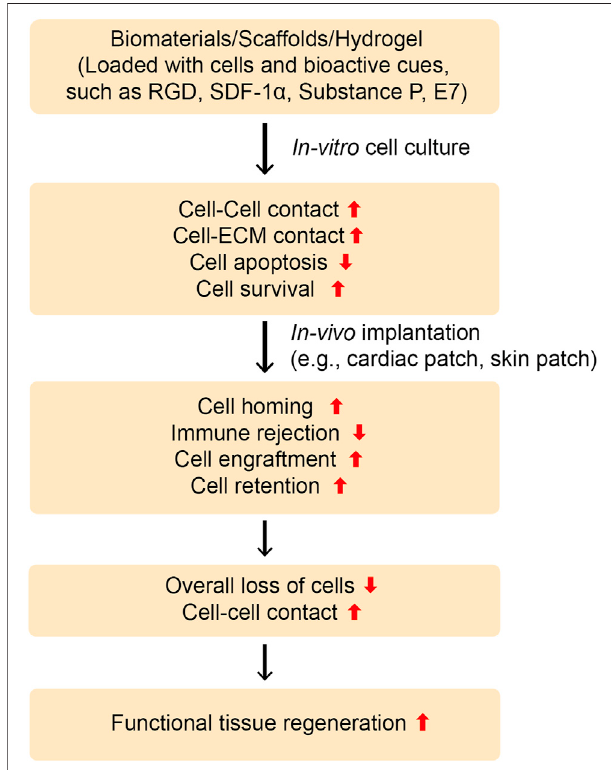
FIGURE 4 | Designing instructive biomaterials for tissue regeneration applications.Toamelioratecell-celland cell-ECM contacts andimpactcellular behavior, instructive biomaterials can be designed by installing an array of functional moieties on biomaterials, such as cell-adhesive ligands like RGD or laminin-derived bioactive cues (IKVAV or YIGSR), the MSCs-af fi nity peptide “ E7 ” , or the EPCs-capturing peptide “ TPS ” . Furthermore, cell inducing/recruiting factors can be incorporated into biomaterials to improve stemcellmobilization, homing,and recruitment invitro and invivo .Variouscell inducing and recruiting factors, including SDF-1 α and SP have been integrated into biomaterialsand shown topromote cell homingand migration. These bioactive cues could be central to ameliorate cell-cell and cell-ECM contacts as well as improve cell survival and retention during tissue regeneration in vivo . Overall, this can lead to functional tissue